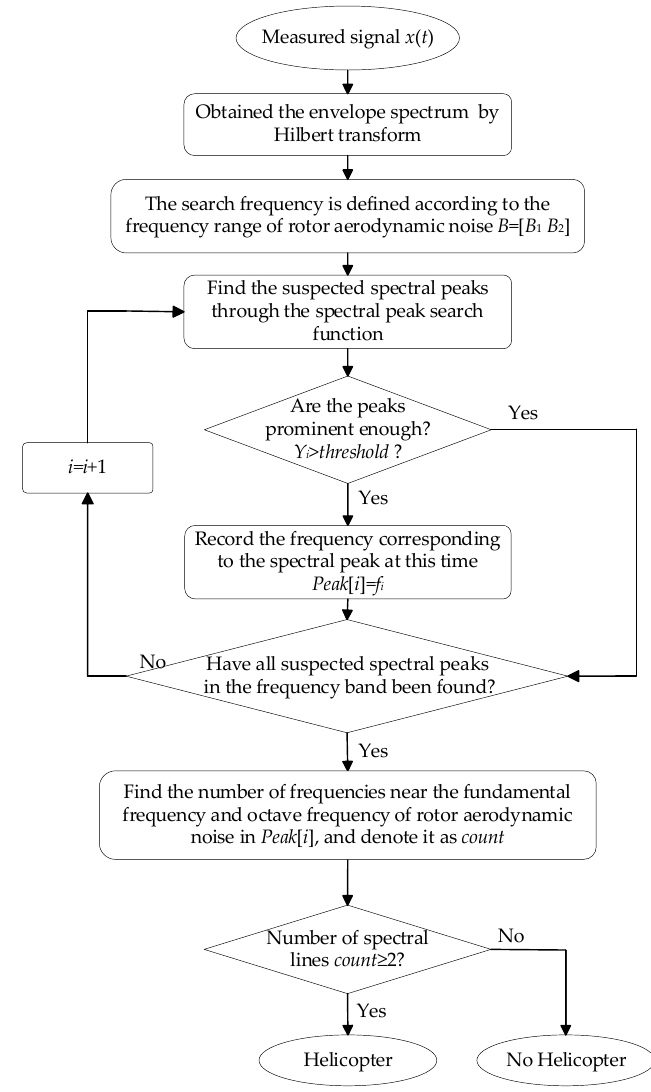
Figure 14. Flow chart of detection algorithm of helicopter.